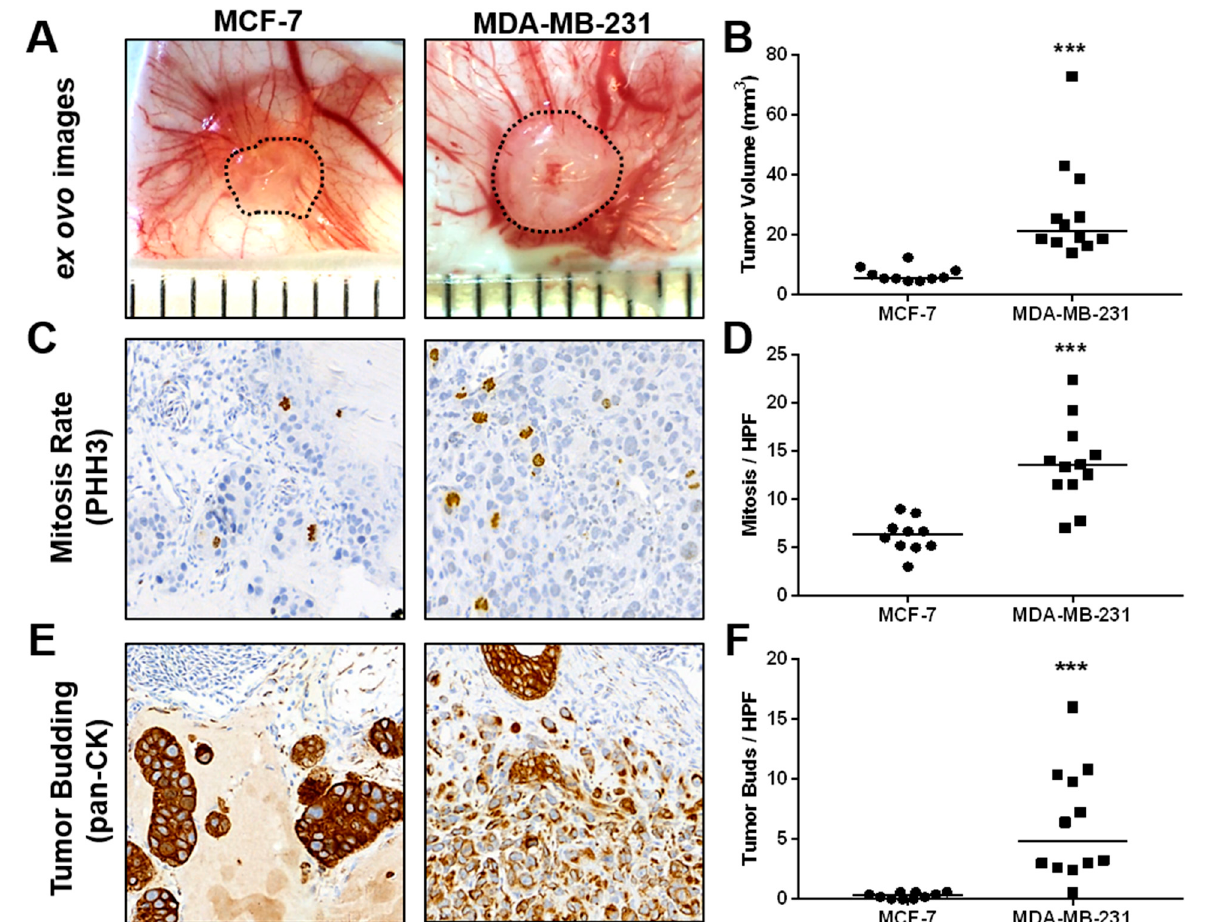
Figure 4. In vivo growth and characterization of tumor aggressiveness of MCF-7 and MDA-MB-231 breast cancer cells in the CAM xenograft assay. ( A ) Example ex ovo images of CAM ovografts harvested five days post-engraftment of MCF-7 and MDA-MB-231 cells onto the CAM of fertilized SPF chicken embryos. Scattered lines indicate tumor boundaries. Individual ruler segments define a length of 1 mm. ( B ) Tumor volume of ovografts after 5 days of incubation on the CAM. ( C ) Representative images of mitotic figures as detected in PHH3-stained tissue sections of MCF-7 and MDA-MB-231 CAM ovografts. ( D ) In vivo mitotic rate of MCF-7 and MDA-MB-231 cells as de- termined by the average number of mitotic figures per high-power field (HPF) in PHH3 IHC-stained tissue sections of CAM ovografts. ( E ) Example images of pancytokeratin-stained tissue sections of MCF-7 and MDA-MB-231 CAM ovografts as applied for the assessment of invasiveness and tumor budding at the tumor invasion front. ( F ) Tumor budding rate of MCF-7 and MDA-MB-231 cells as determined by the average number of tumor buds per HPF at the tumor invasion front in pancytokeratin-stained tissue sections of CAM ovografts. All data are presented with medians, and statistical analyses were performed using the Mann-Whitney test; MCF-7: n = 10, MDA-MB-231: n = 12; *** indicates p <